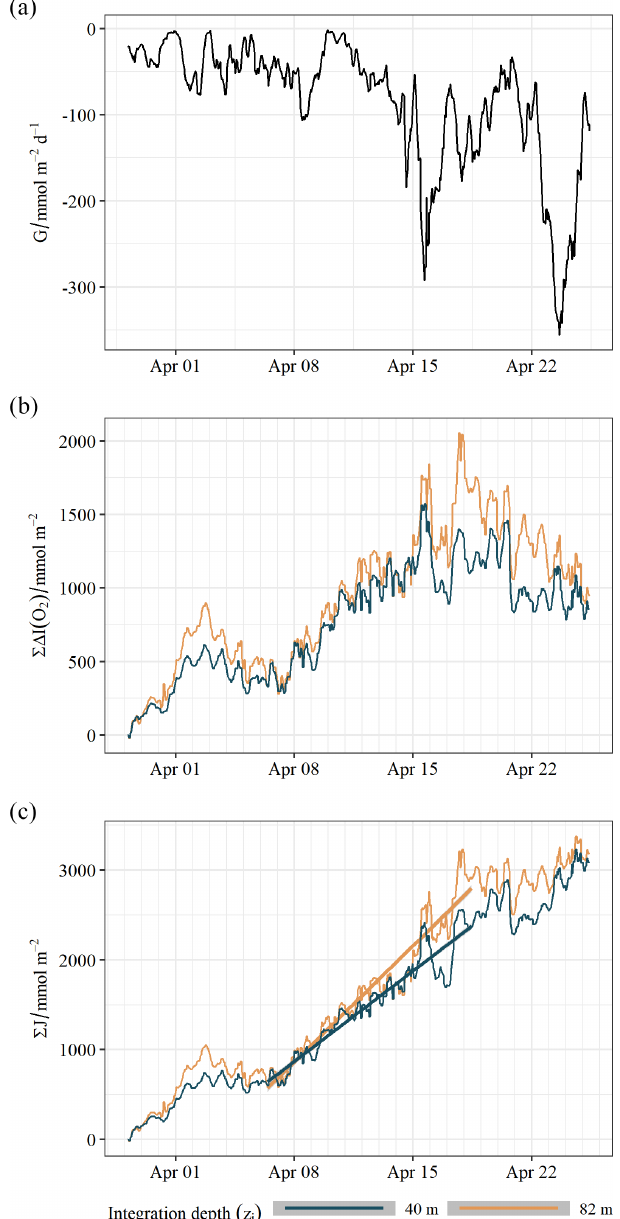
Figure 4. Oxygen mass balance. (a) Air–sea oxygen gas exchange with a negative sign signifying a flux out of the ocean. (b) The change in depth-integrated oxygen inventory. (c) Cumulative net community production. Lines indicate linear model fit to the period associated with nitrate